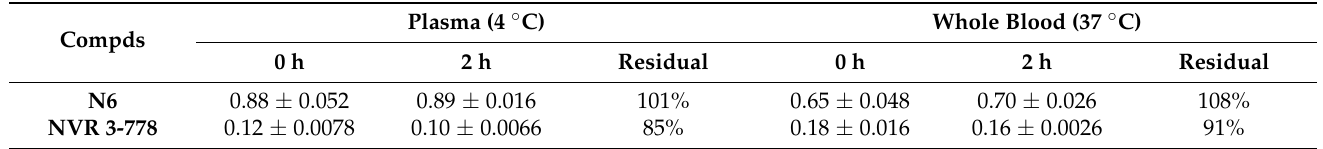
Table 3. Stability of NVR 3-778 and N6 in plasma at 4 ◦ C and whole blood at 37 ◦